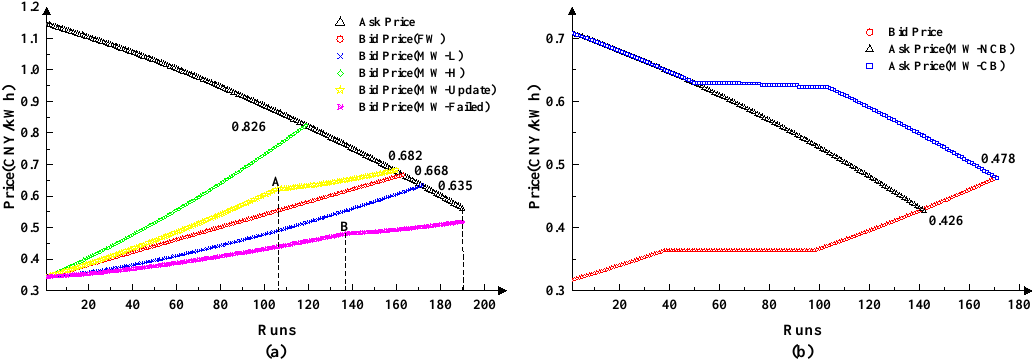
Figure 7. The influences of the multidimensional willingness proposed in the paper on bidding results: ( a ) trading performance of the bid price under fixed willingness (FW), low multidimensional willingness (MW-L), high multidimensional willingness (MW-H), updated multidimensional willingness (MW-Update), and failed multidimensional willingness (MW-Failed); ( b ) trading performances of the asking price under multidimensional willingness without counter behavior (MW-NCB) and multidimensional willingness with counter behavior